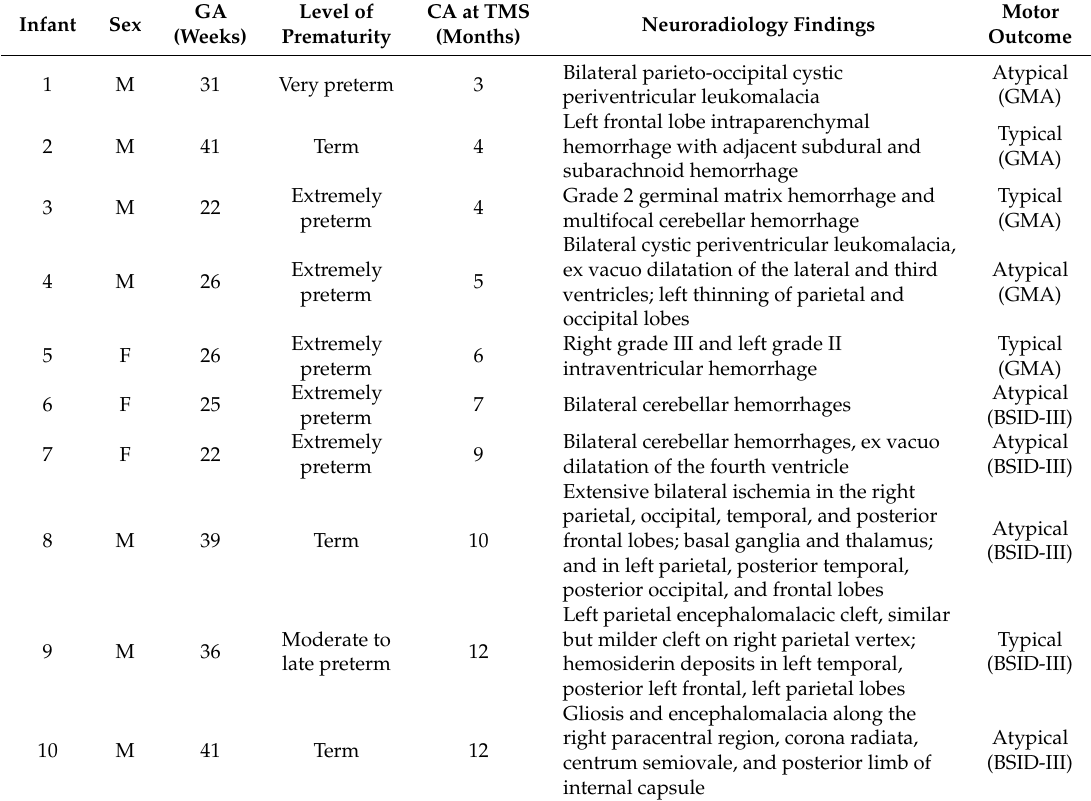
Table 1. Infant clinical